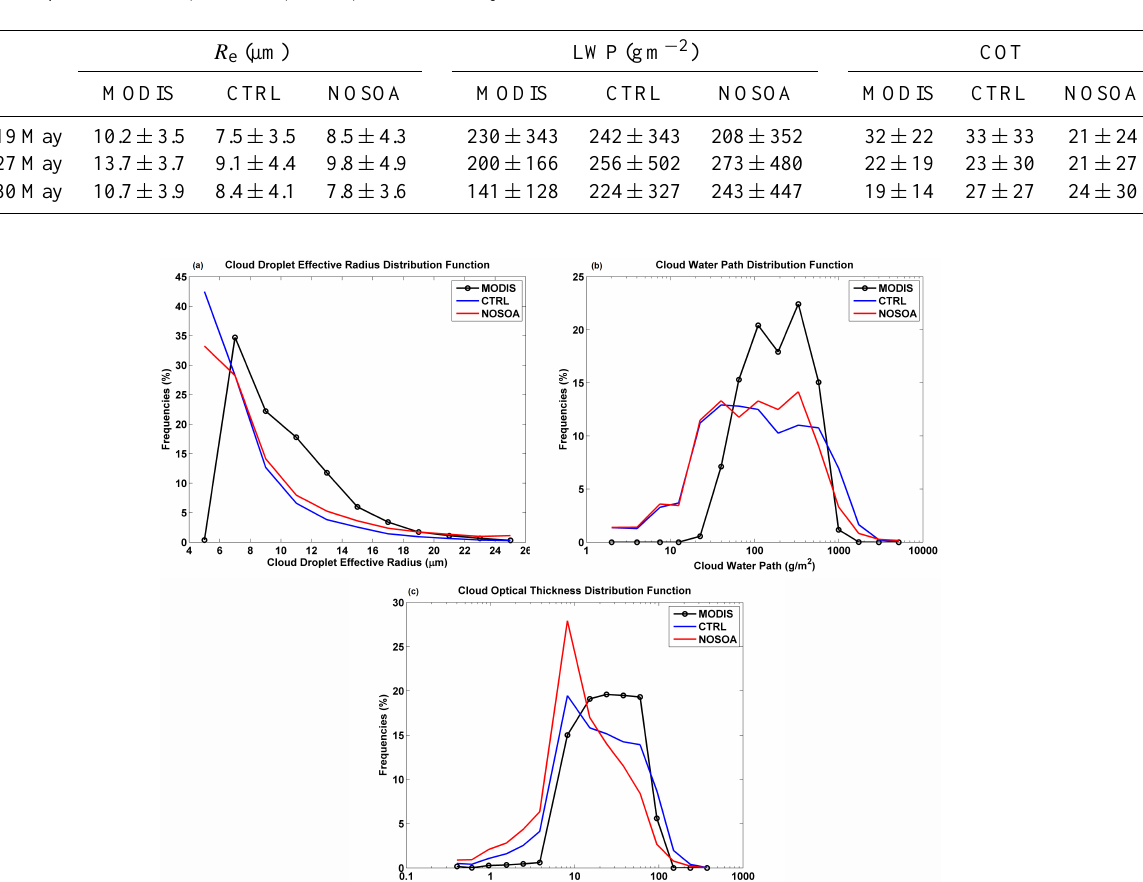
Table 4. MODIS and modelled mean values and standard deviations of droplet effective radius at cloud top, liquid cloud water path, and liquid cloud optical thickness, on 17–19, 25–27, and 28–30 May 2008.